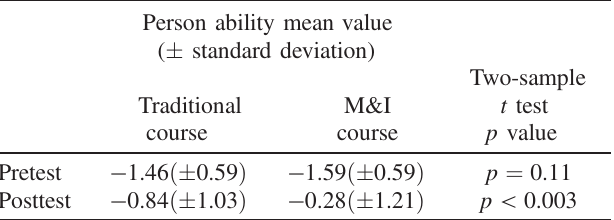
TABLE III. Pre- and posttest person ability estimates for students in the traditional and M&I physics courses.